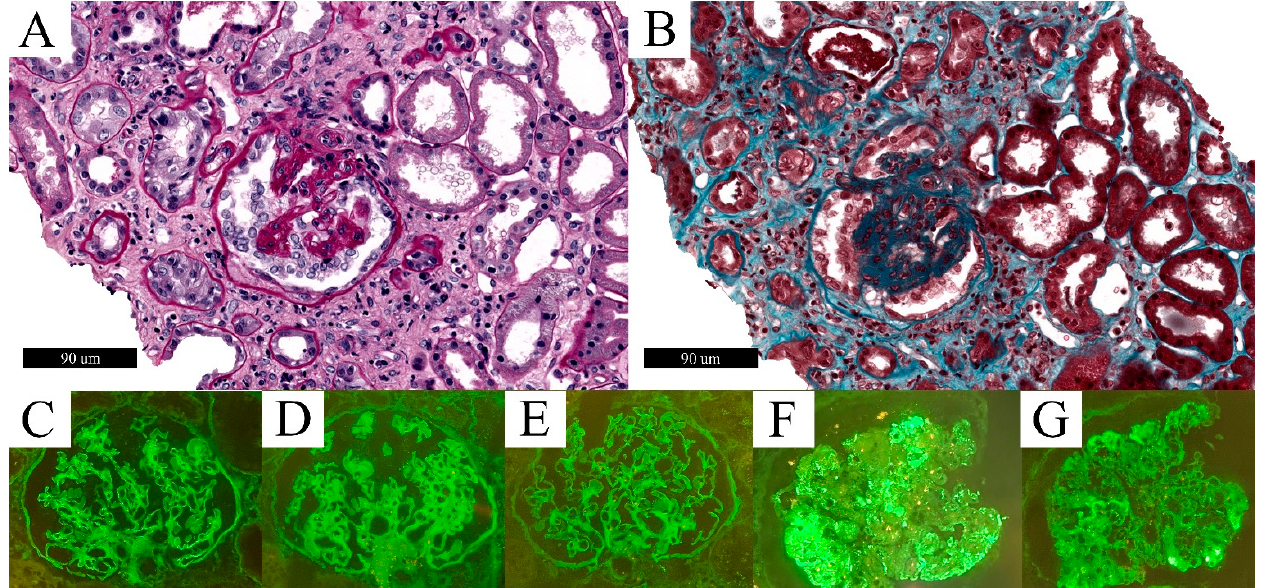
Figure 3. Histomorphological and IF features of Case 3. PAS stain ( A ) showed global collapse of glomerular tuft with overlying hypertrophy and hyperplasia of podocytes, highlighted by trichrome stain ( B ). IF showed mild and diffuse linear positivity for IgG ( C ), Lambda light chain ( D ), and Kappa light chain ( E ), while IgM ( F ) and C3 ( G ) were positive in sclerotic areas.